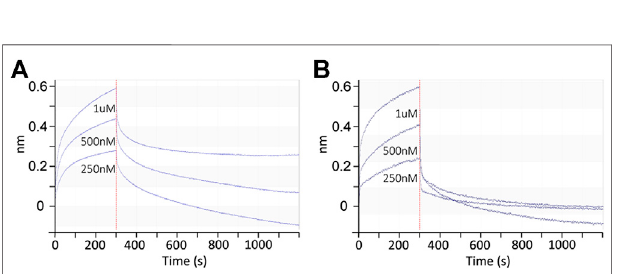
FIGURE 4 | Binding kinetics between the Siglec-10-Fc chimera protein homodimer and Neu5Gc-containing N -glycans 102 (A) and 106 (B) determined by BLI. Association and dissociation phases are shown and separated by the red dashed line at 300 s.